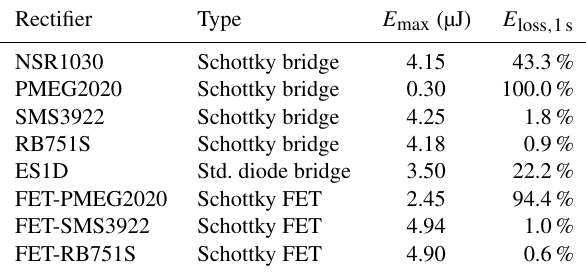
Figure 4. Frequency dependency of energy output of the Wiegand effect compared to regular induction. A coil (8000 windings) is placed in an oscillating external magnetic field of 16mT amplitude while the Joule heating power in a 3k (cid:127) resistor is measured. The coil is filled with a standard ferromagnetic material (orange) or Wie- gand generator (green).